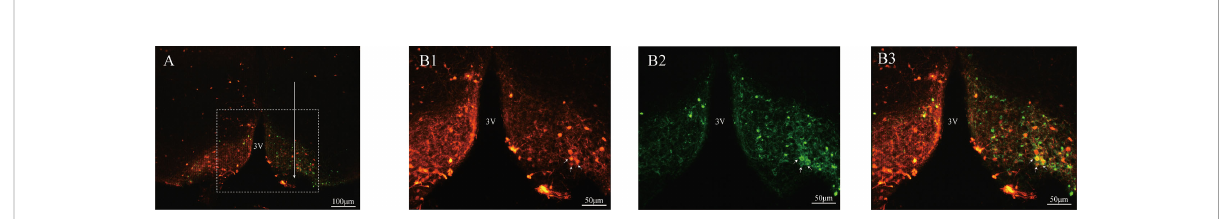
FIGURE 1 Expression ChR2-EYFP in ARC kisspeptin neurons of Kiss-Cre-tdTomato mice. The brain sections were obtained from Kiss-CRE;tdTomato mice to verify the co-expression of ChR2-EYFP with Kisspeptin neurons. The injection tract in the ARC is shown by the white arrow in (A) . (B1 – B3) Represent the magni fi ed area of the region shown by the white box in A , and illustrate the Kiss1 ARC neurons (red), ChR2-EYFP expressing neurons (green) and ChR2-EYFP co-localized with Kiss1 ARC neurons (yellow)